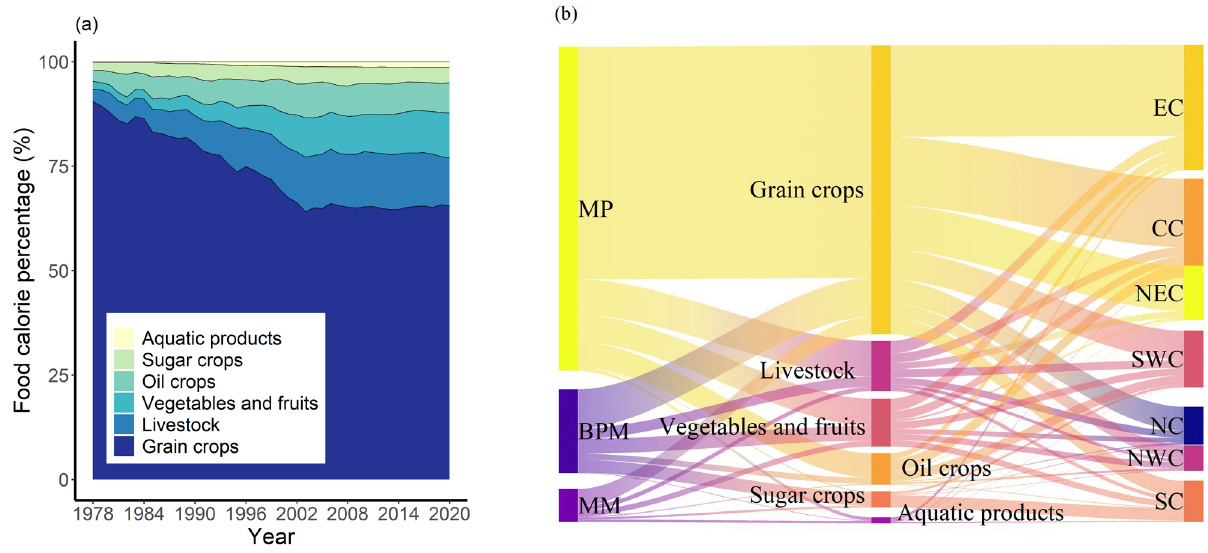
Figure 3. Food caloric production in different categories of food: ( a ) food calorie contribution for different categories of food from 1978 to 2020; ( b ) calorie production of six categories of food in production and marketing sub-regions and physical geographic divisions in 2020.